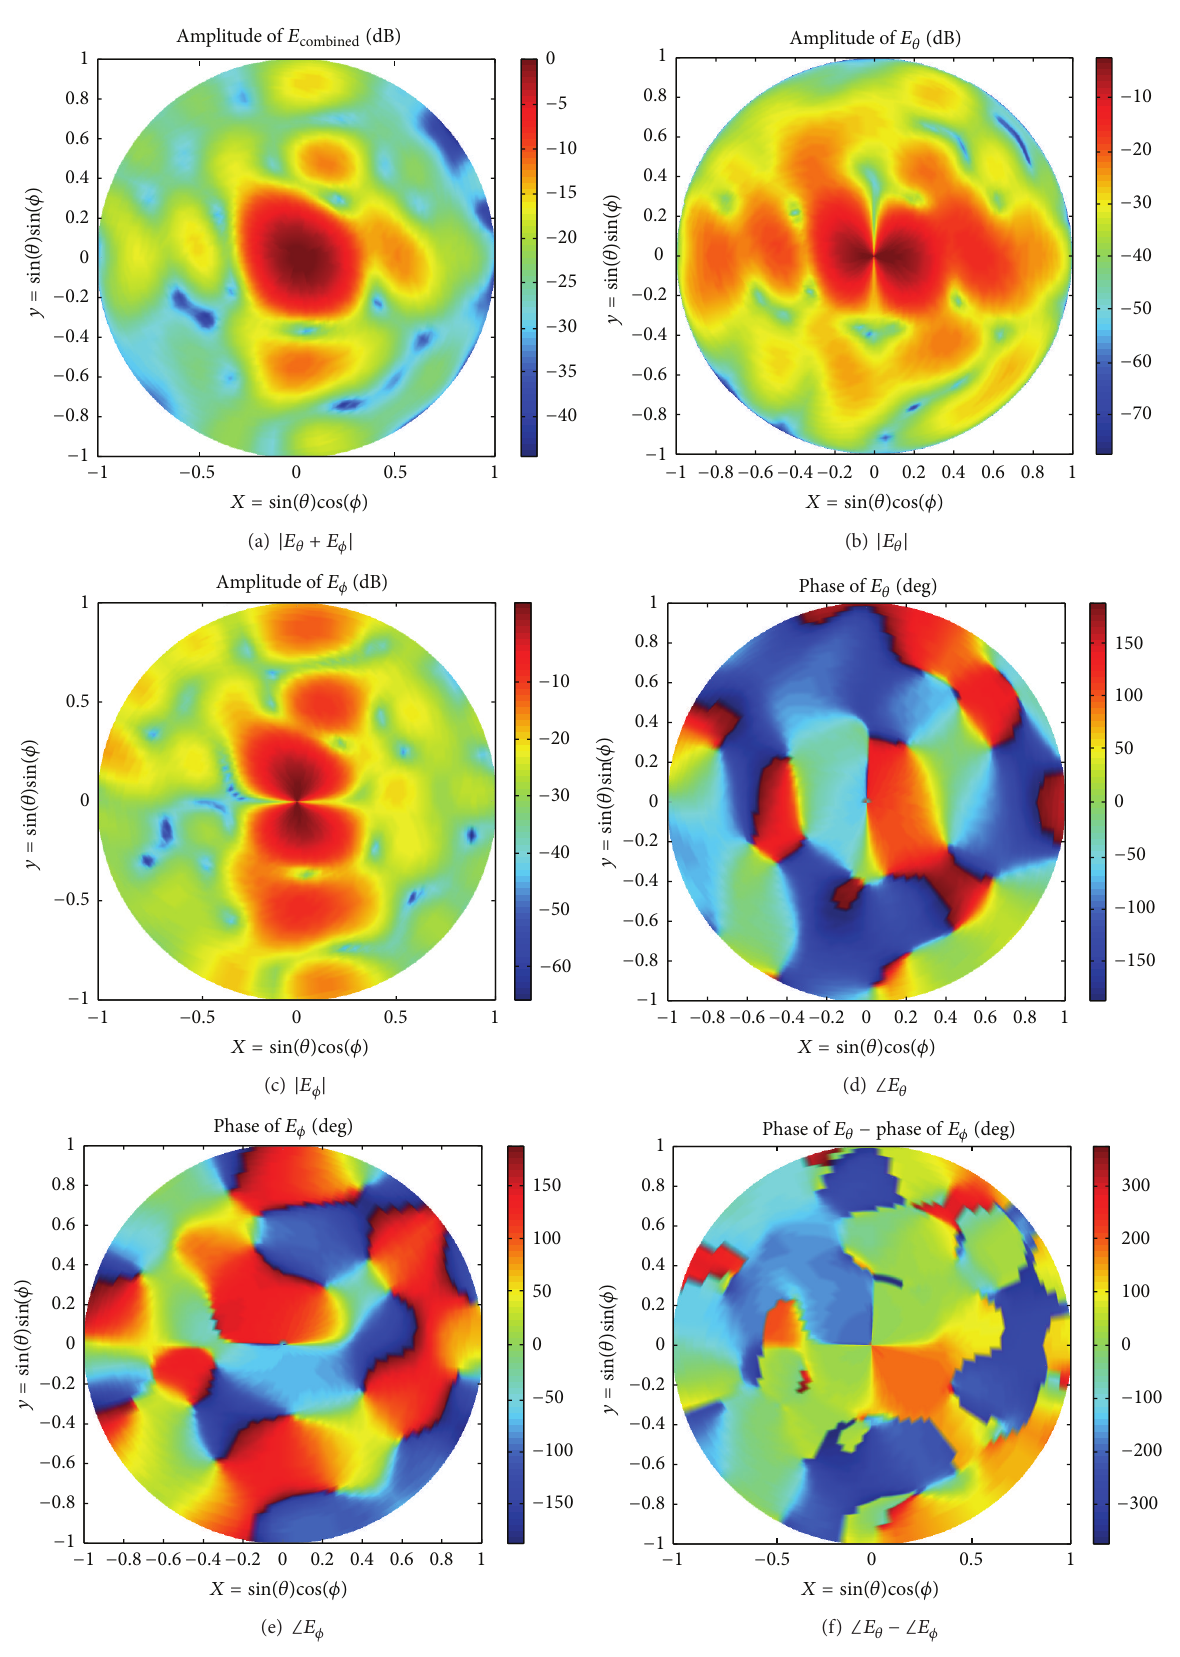
Figure 14: Measured 3D transmitting pattern of the planar 4 × 4 (nonmirror) CPAD